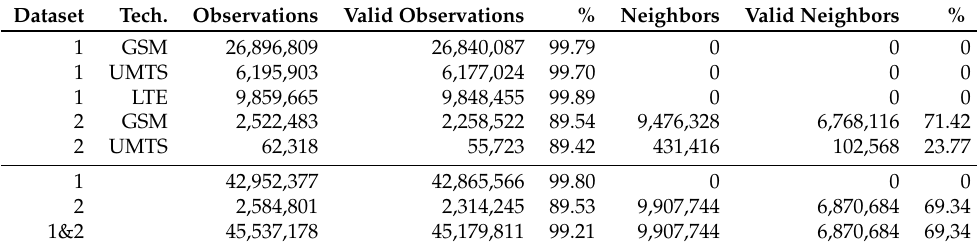
Table 3. Measurements (1 = OpenCellID, 2 = u-blox).